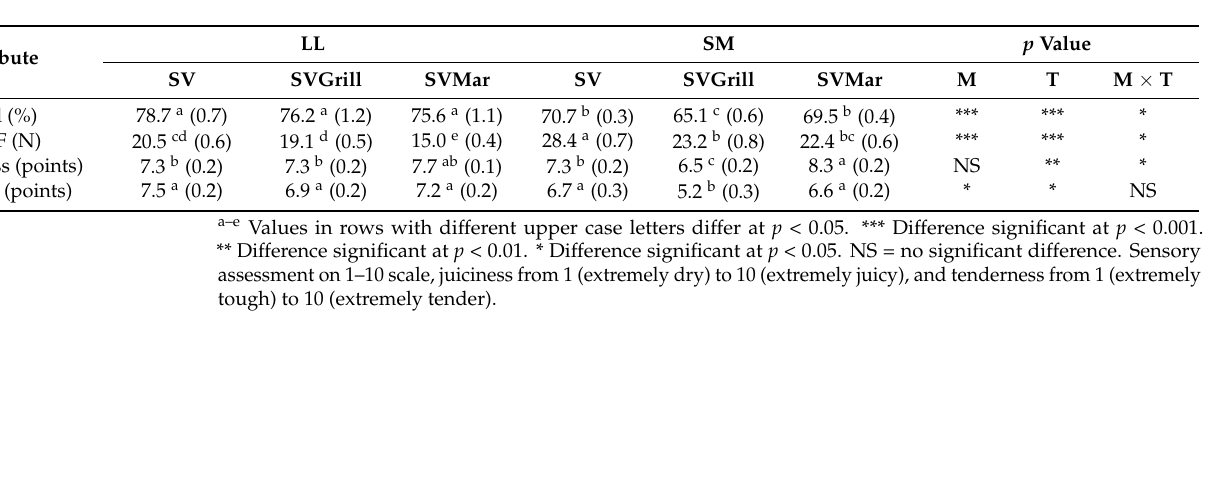
Table 3. Effects of muscle (LL: longissimus lumborum ; SM: semimembranosus ) and treatment (SV = sous vide, SVGrill = sous vide and subsequent grilling, and SVMar = marinating and sous vide) on yield, Warner–Bratzler shear force (WBSF), and sensory-assessed juiciness and tenderness (mean values and standard error of the mean in